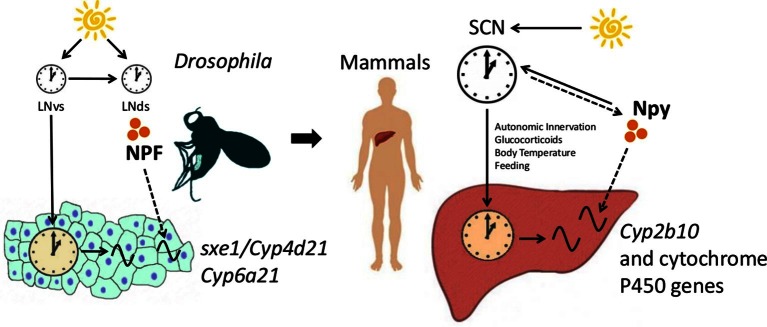
NPF/Npy regulate rhythmically expressed P450 enzymes in the periphery of flies and mammals.A model of brain clock regulation of peripheral cycling. Brain clocks regulate clocks in peripheral tissues. In Drosophila, clocks in PDF-positive neurons (LNvs) regulate the clock in the fat body. Similarly, in mammals, clocks in the suprachiasmatic nuclei (SCN) have been shown to regulate peripheral clocks such as the liver clock via autonomic innervation, glucocorticoids, body temperature, and feeding. In both the fat body and liver, not all circadian transcripts depend on the local-tissue clock. Clocks in NPF-positive LNds and NPF itself regulate circadian expression of cytochrome P450 enzymes in the fly fat body. The LNvs can influence other brain clocks (such as the LNds), but are not required for rhythms of fat body transcripts in LD as LNds may entrain directly to light. In mammals, Npy was previously known to be a non-photic signal involved in entraining the SCN. However, the SCN could also influence Npy production or release, which in turn drives rhythmic expression of cytochrome P450 enzymes in the liver.